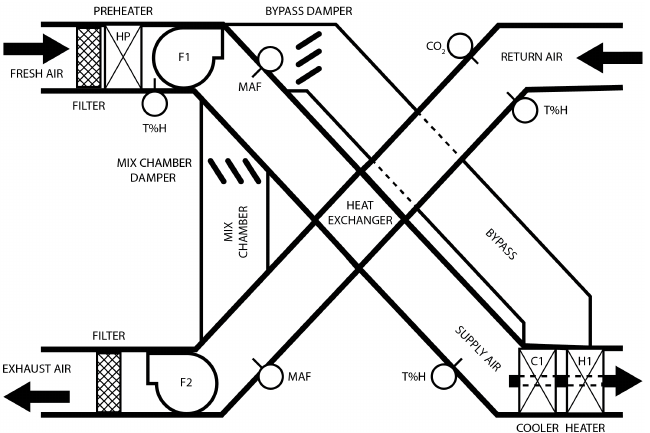
Figure 2. Overview of a typical air handling unit